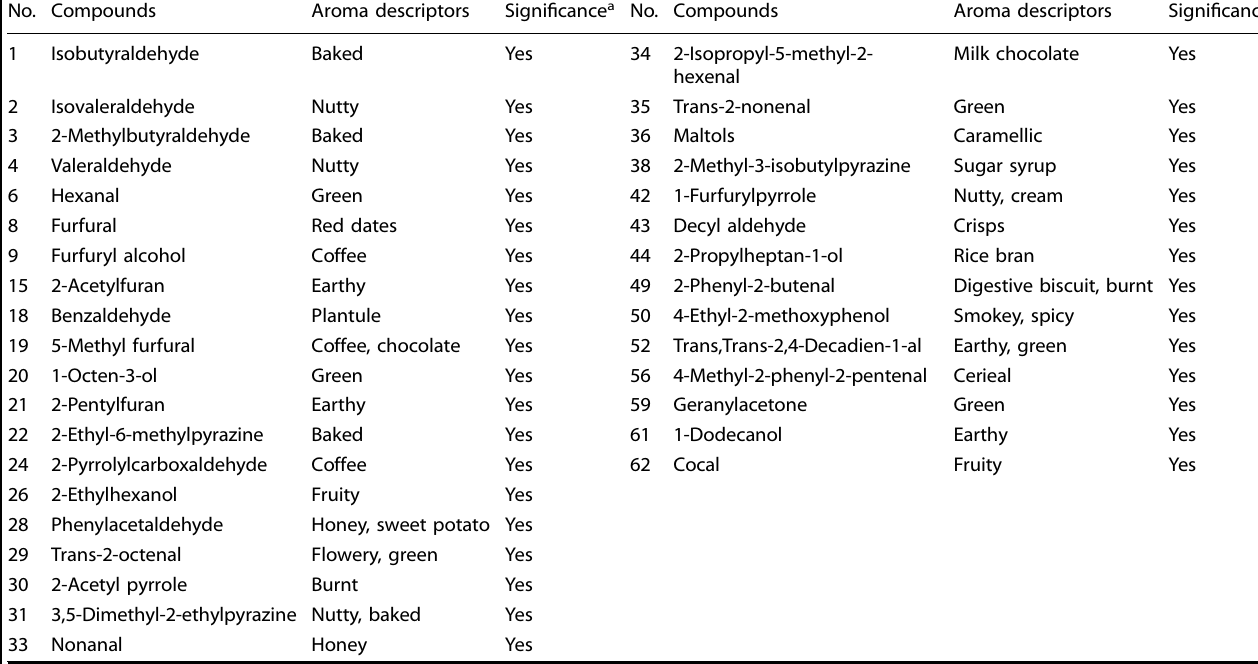
Table 4. The aroma compounds in brewing